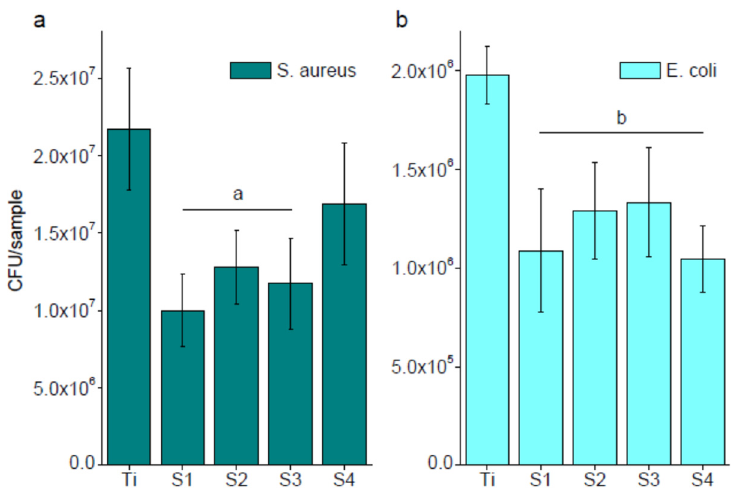
Figure 12. S. aureus ( a ) and E. coli ( b ) adhesion on plasma-polymerized HEMA samples. a indicates statistically significant differences compared with Ti in the S. aureus assay, and b indicates statistically significant differences compared with Ti in the E. coli assay. ( p < 0.05).